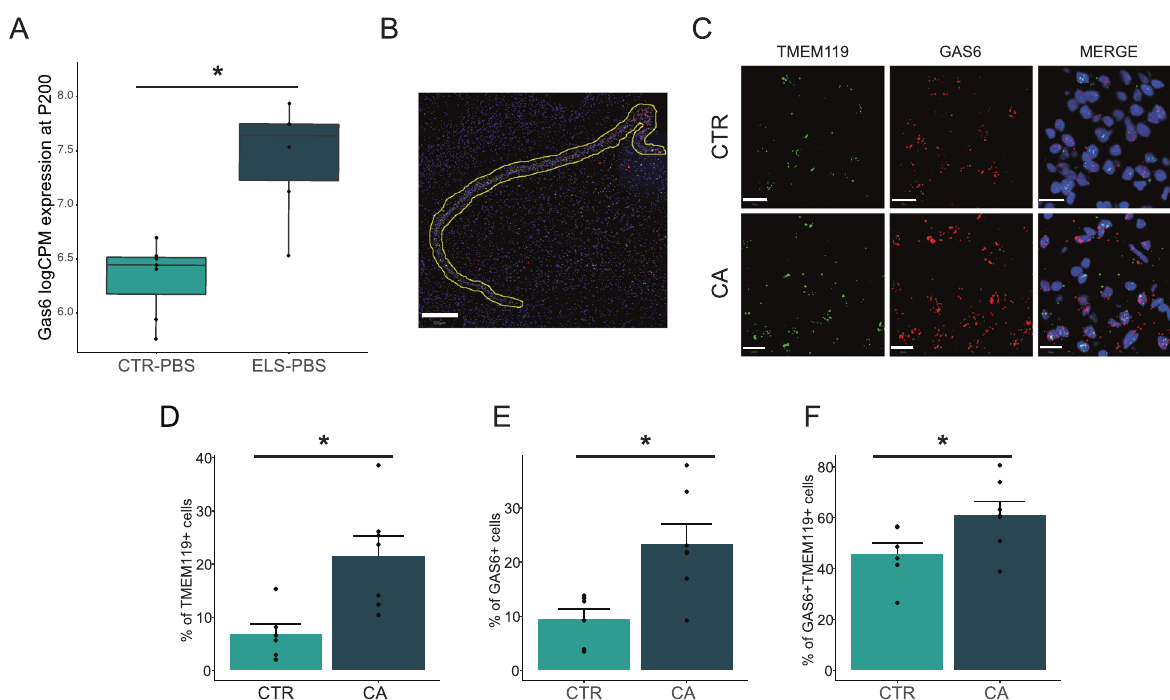
Fig. 5 GAS6 expression is increased in mouse and human hippocampal microglia following ELS. A Increased expression of microglial Gas6 in mice following early-life stress was validated in B human post-mortem dentate gyrus (DG) using RNAscope fl uorescent in situ hybridization. Hippocampi from male depressed suicide subjects with a history of childhood abuse (CA, n = 7) were compared with age-matched control samples (CTR, n = 6). TMEM119 was used to probe microglia. Scale bar: 500 µm. C Representative image depicting CA-associated changes in the number of cells expressing GAS6, TMEM19, and double positive cells. The number of subpopulations expressing the mRNA of interest were counted and shown as percentage to total cells detected using DAPI staining. Scale bar: 20 µm. CA is associated with a signi fi cant increase in D microglia counts as identi fi ed by TMEM19 + cells, E total GAS6 + cells, and F microglia expressing GAS6 + , detected by cells positive for both TMEM19 and GAS6. Data were analyzed using a two-tailed t test. *, condition effect, p < 0.05. CTR control, CA childhood abuse. Center values in the box plots represent the mean, borders represent the fi rst and third quartiles, and whiskers represent 1.5*IQR value. Bar graphs represent mean and